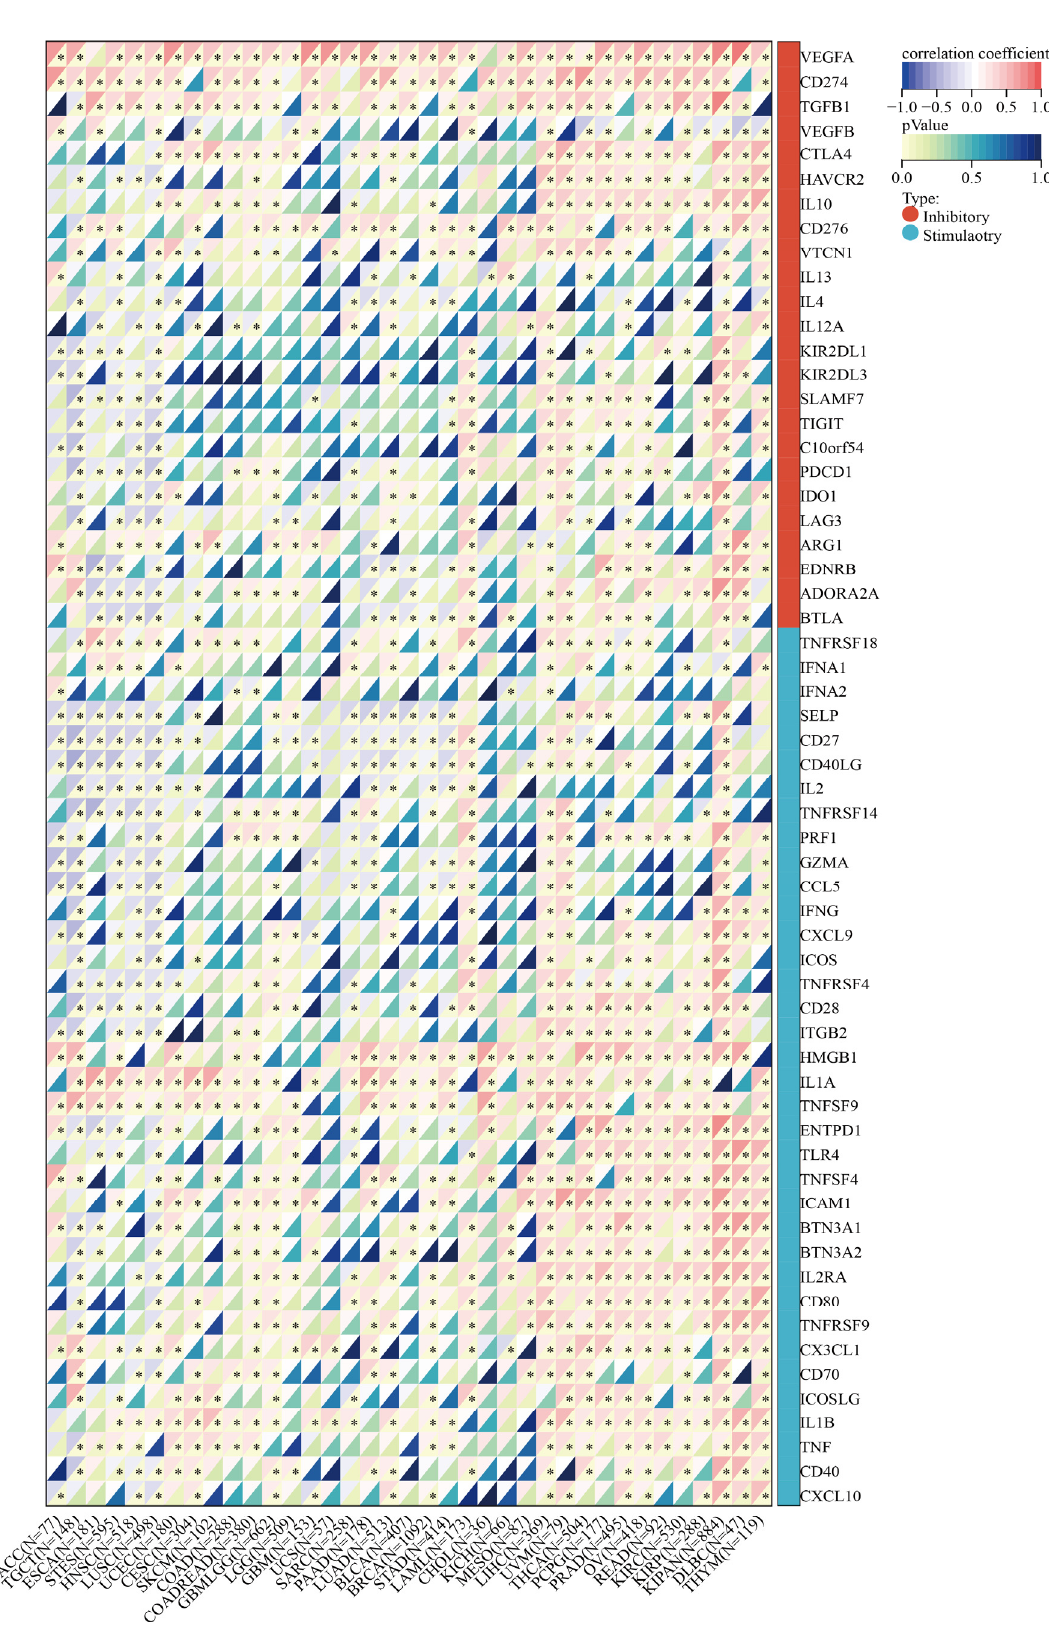
Figure 14. Correlation between SLC2A1 and ICP genes (*, p < 0.05).